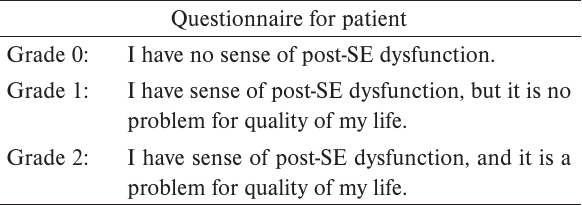
Table 1. Severity of difficulties after sympathectomy, Grade 0-2. Questionnaire for